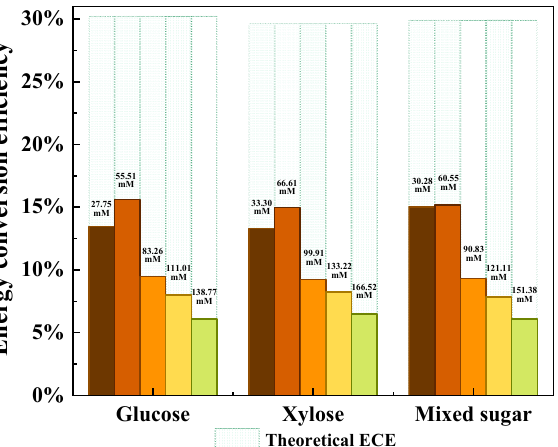
Figure 7. Energy conversion efficiencies of bio-hydrogen production from glucose, xylose, and glucose–xylose at varying concentrations.